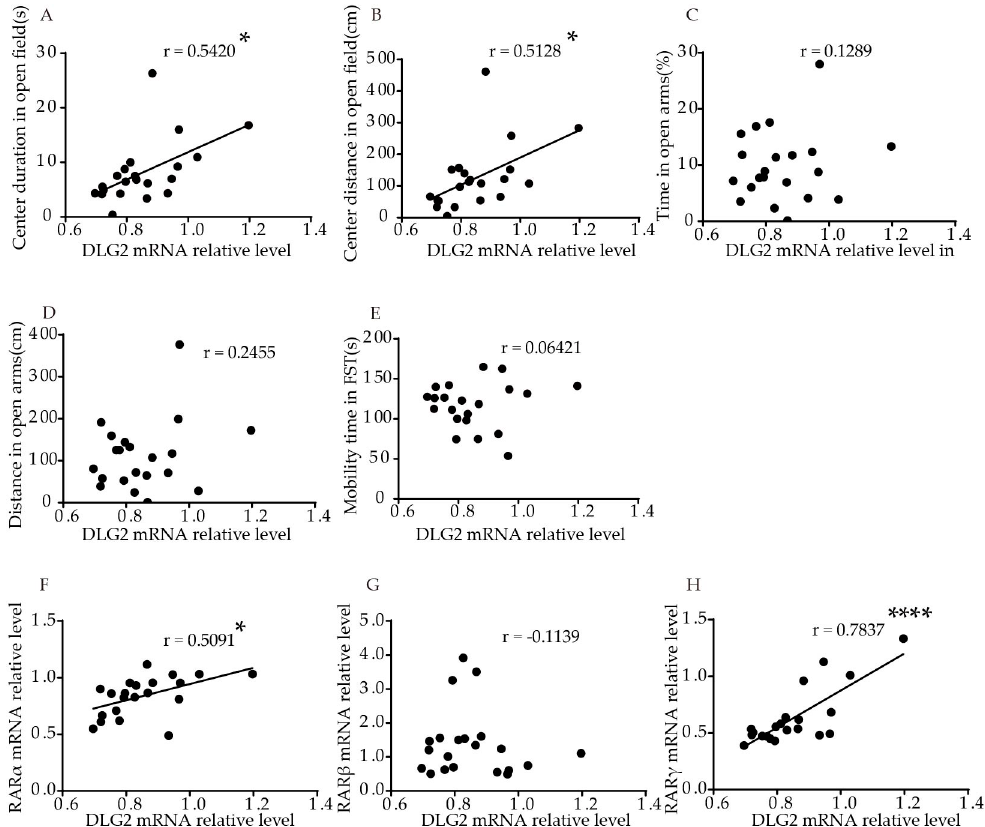
Figure 4. Correlation of DLG2 mRNA levels in the hippocampus with behavior and RARs mRNA levels in young mice. Correlation between mRNA levels of DLG2 in the hippocampus and ( A ) center duration, ( B ) center distance in OFT, ( C ) duration, and ( D ) distance in the open arms in EPM, ( E ) mobility time in FST. Correlation between mRNA levels of DLG2 in the hippocampus and ( F ) RAR α , ( G ) RAR β , and ( H ) RAR γ . Correlation analysis was performed using Pearson’s correlation test. * p < 0.05, **** p < 0.0001.